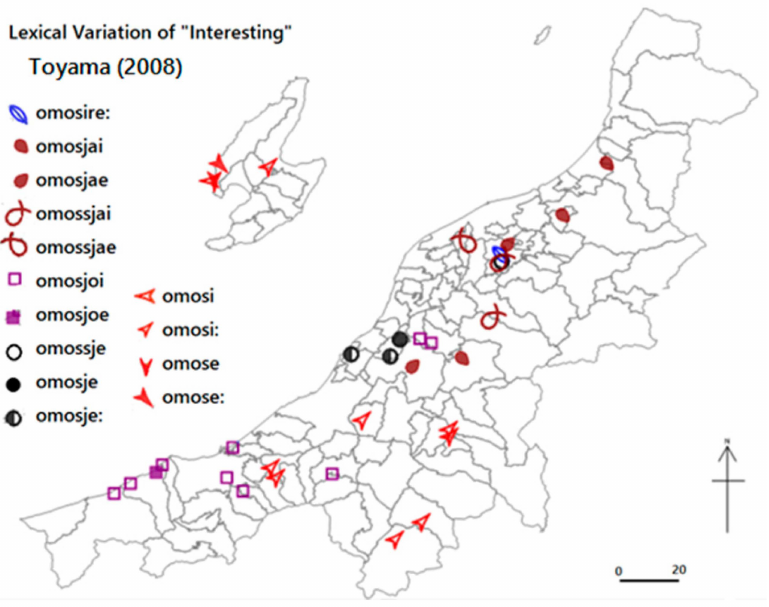
Figure 10. Lexical variation of omoshiroi “interesting” in Niigata: Toyama data.